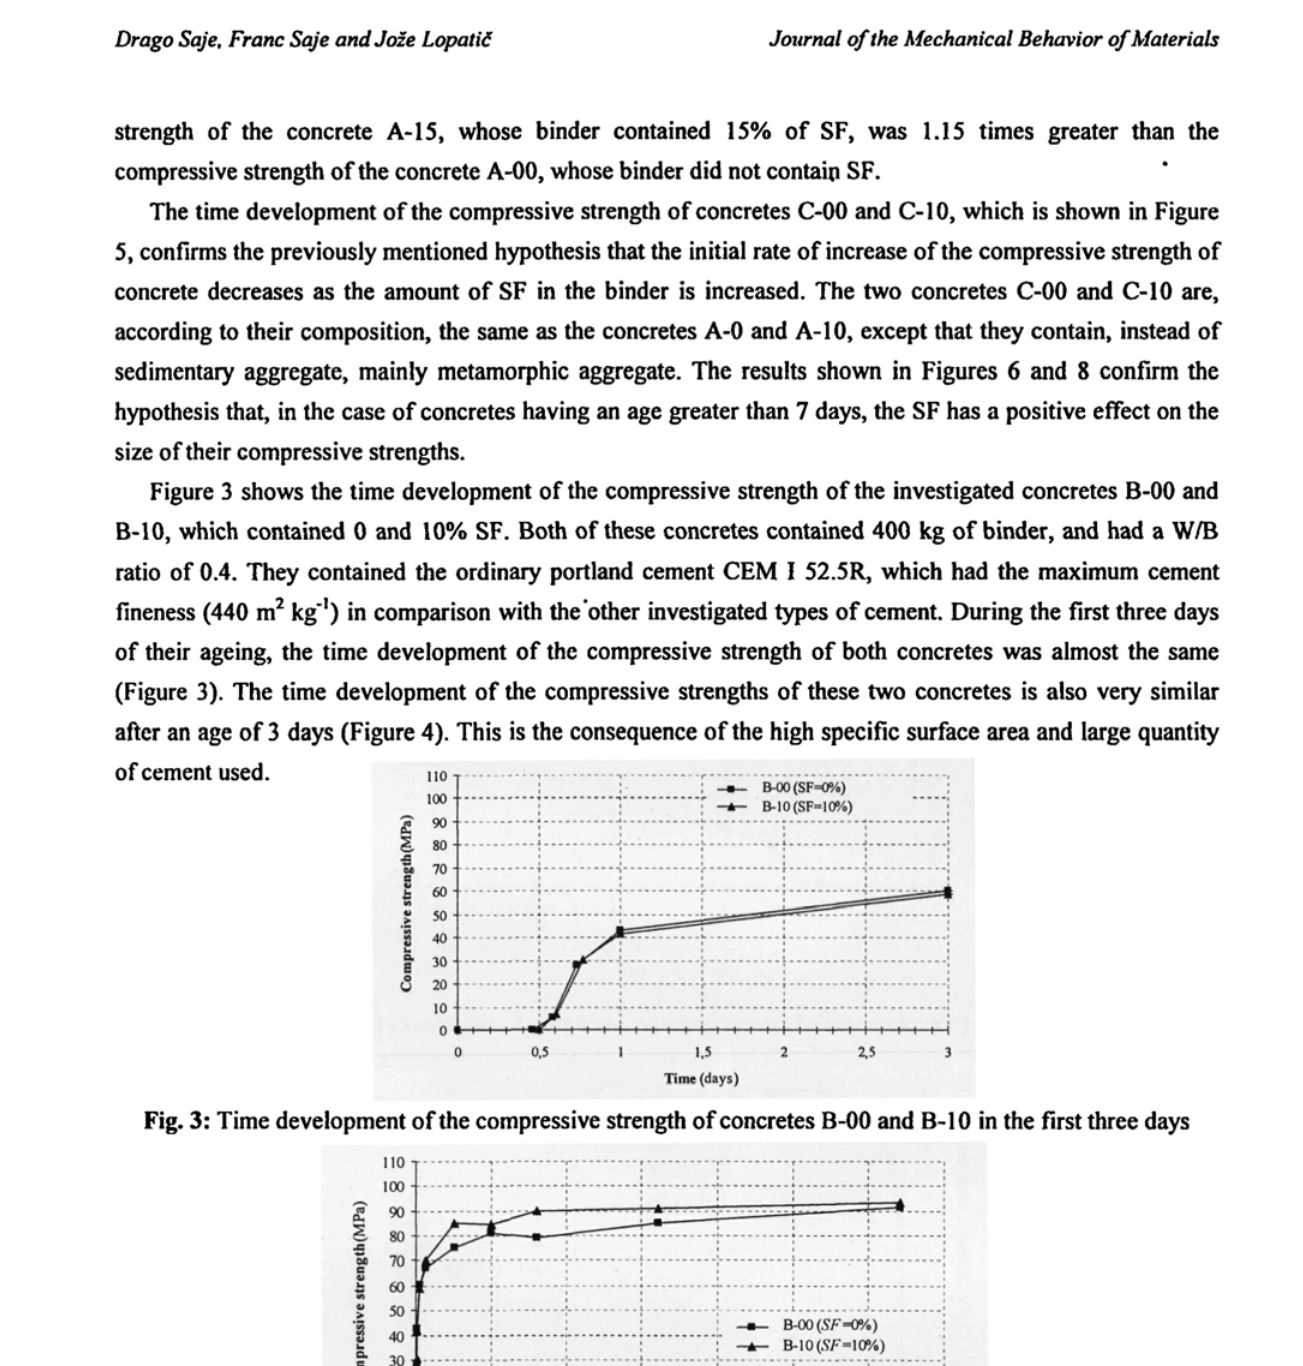
Fig. 4: Time development of the compressive strength of concretes B-00 and